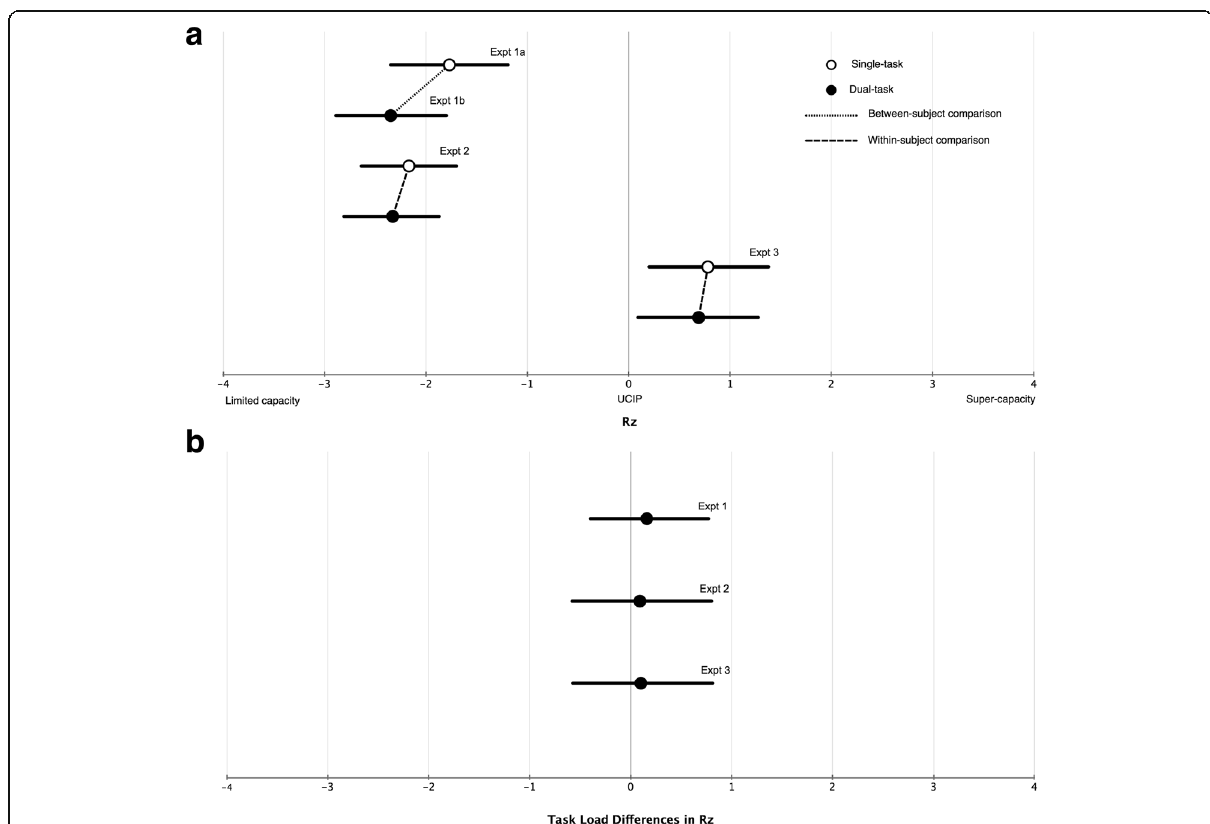
Fig. 4 a Means and 95% BCIs for standardized resilience scores in Experiments 1 to 3. b Means and 95% BCIs for task-load differences in Rz (sin- gle-task minus dual-task) across